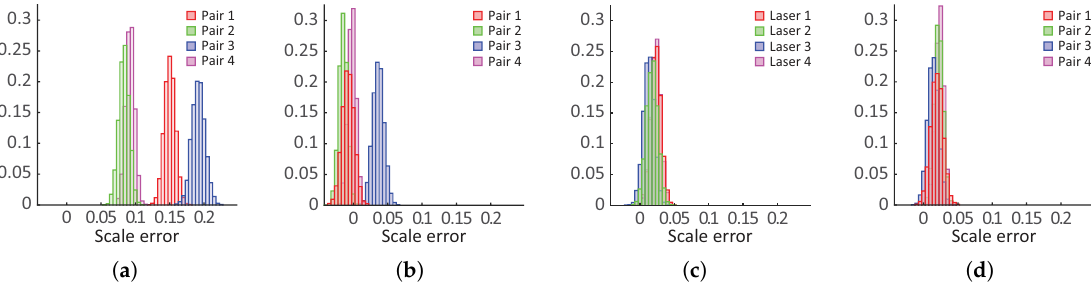
Figure 20. Estimated scale error per laser using different methods of computation: ( a ) Simplistic, ( b ) partially-constrained method, ( c ) fully-unconstrained method, and ( d ) partially-constrained method corrected for errors induced by nonparallelism of laser